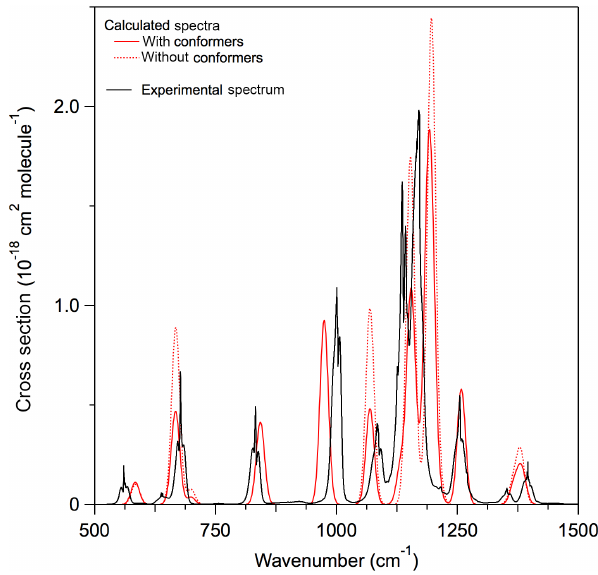
Figure 3. Comparison of experimental and calculated infrared ab- sorption spectrum of HCFC-124a (CHF 2 CClF 2 ) . Calculated spec- tra at B3LYP/6-31G(2df,p) level of theory with (solid red lines) and without (dotted red lines) including stable conformers, and the ex- perimentally measured spectrum (solid black lines) (see Table 1 for the source of the experimental spectrum).